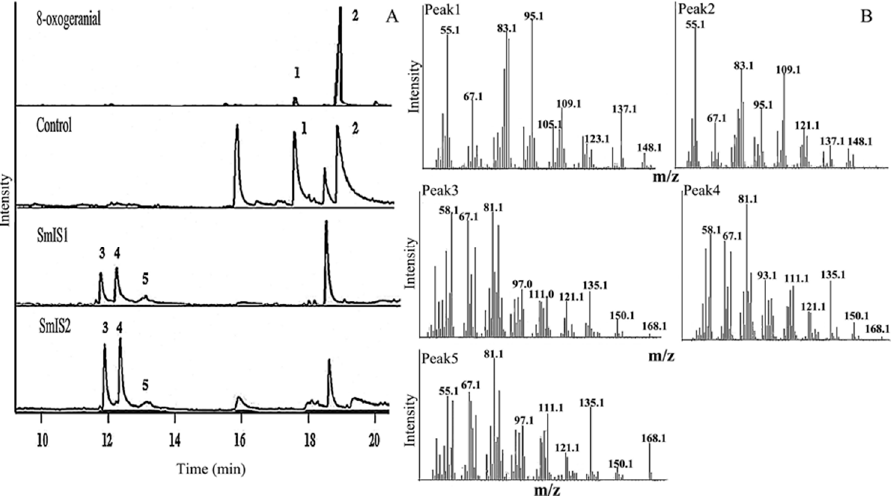
Figure 6. Functional characterization of SmIS1 and Smis2. ( A ) Analysis of the reaction product by GC-MS. Control, the reaction in the presence of denatured SmIS1 or SmIS2 proteins; ( B ) MS spectra of the substrates (peaks 1 and 2) and products (peaks 3, 4, and 5).